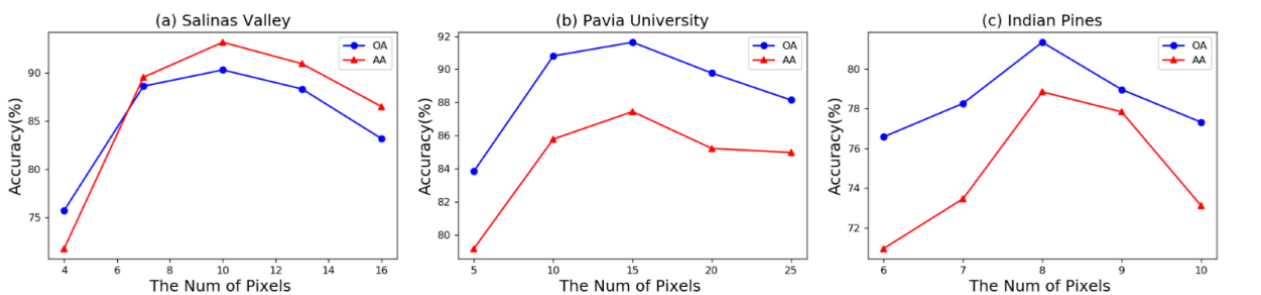
Figure 13. Influence of the number of labeled pixels in each block: ( a ) Salinas Valley, ( b ) Pavia University, and ( c ) In- dian